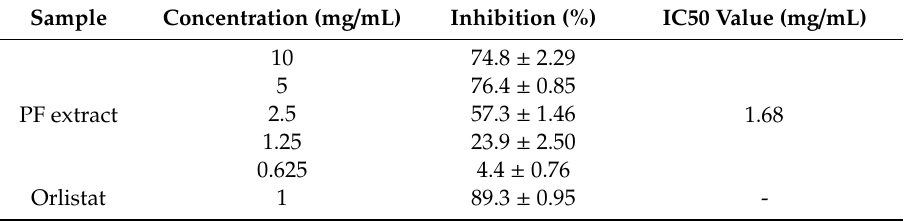
Data are presented as medians ± standard deviations (n =